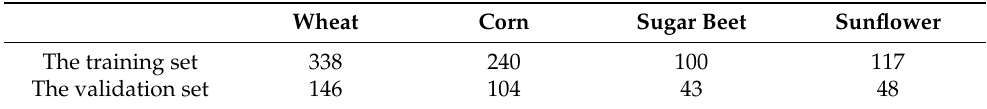
Table 4. The number of samples for each crop type used for